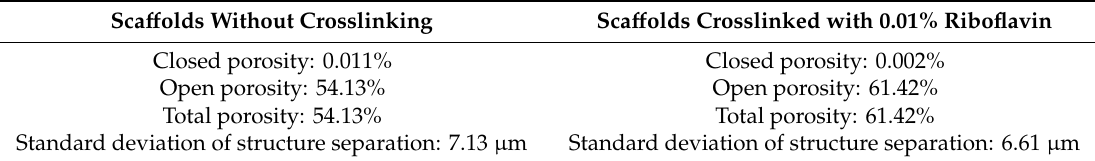
Table 2. Calculations of closed, open and total porosity generated by CTAn